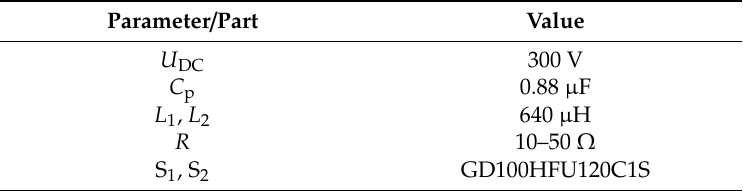
Figure 10. The prototype of the IIEIFR IPT system. Table 2. Component values used in the prototype.